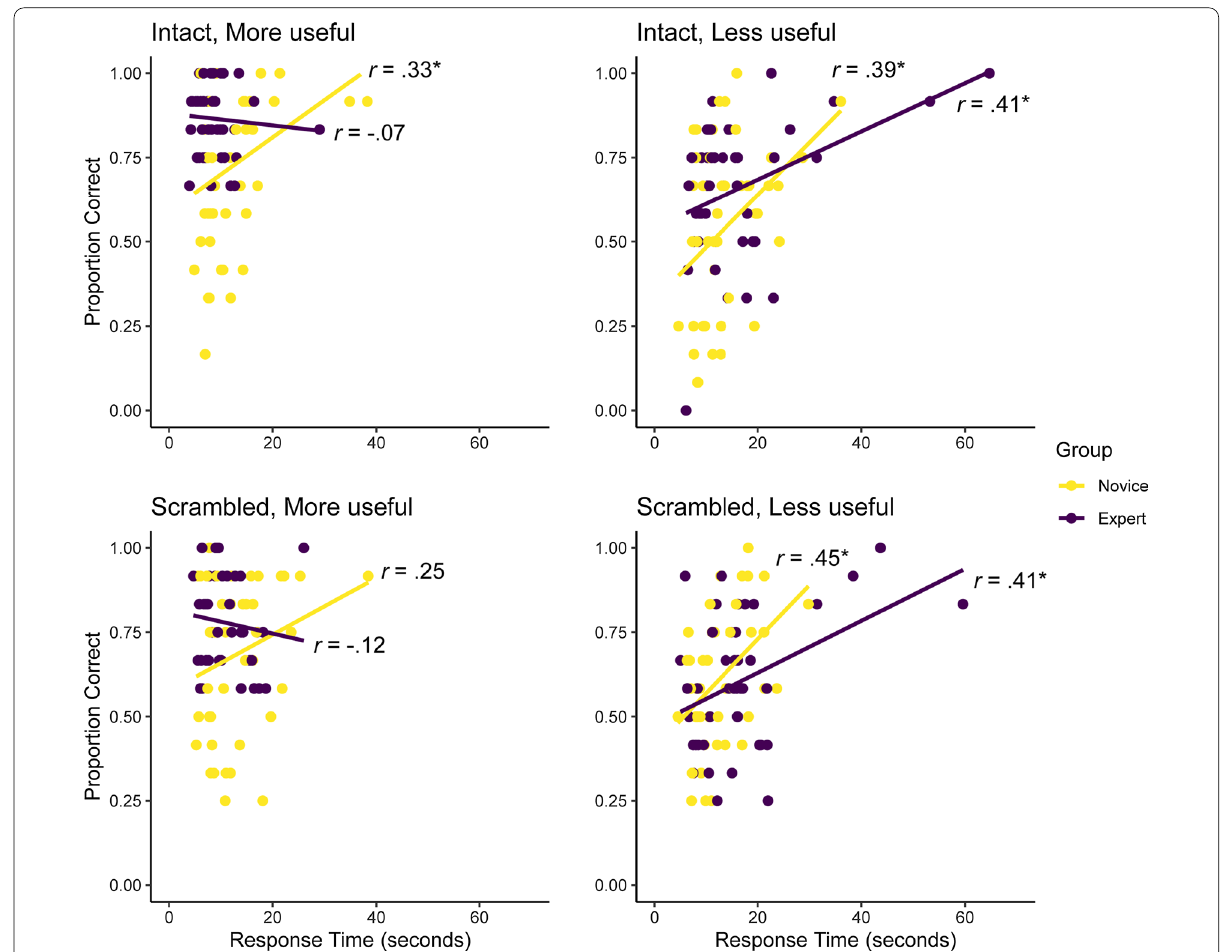
Fig. 2 The correlations between speed and accuracy for each group across the four conditions in the Find-the-Fragment task. An asterisk (*) signifies a significant correlation ( p <